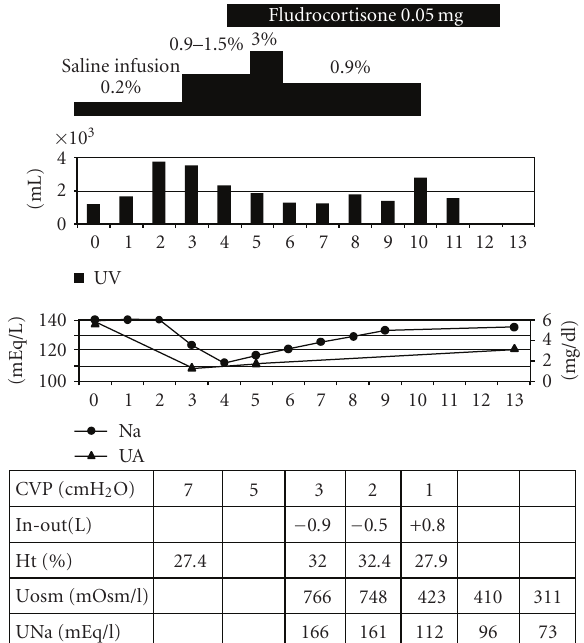
Figure 1: Clinical